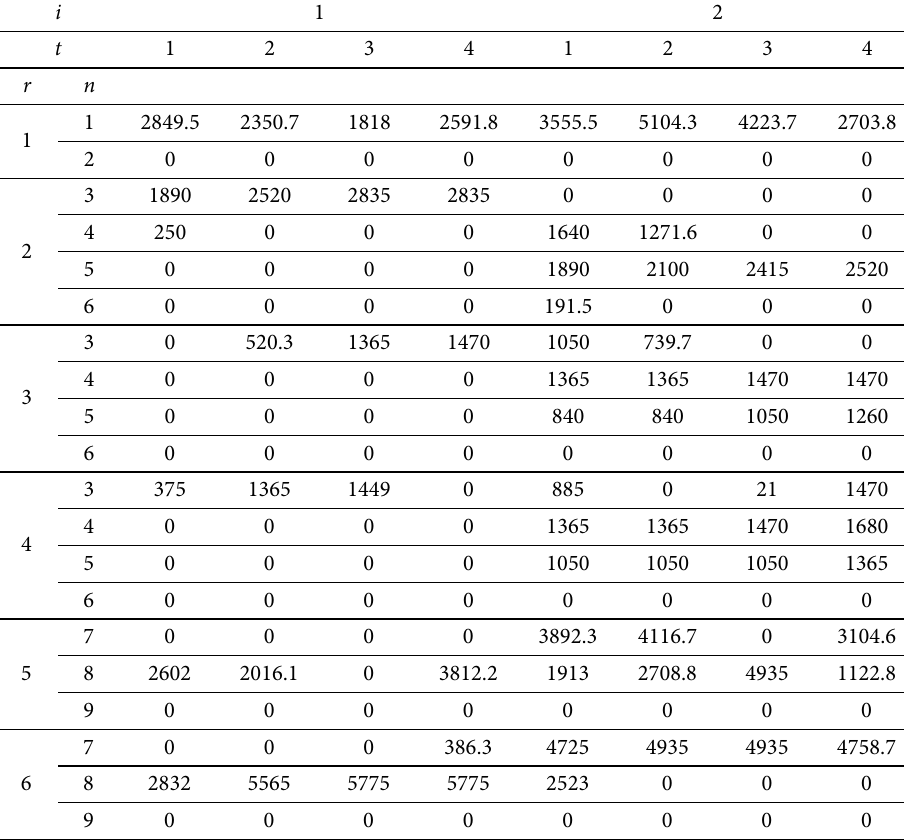
Table 8. The flow of raw materials/components from suppliers to production centers ( FSP rnit